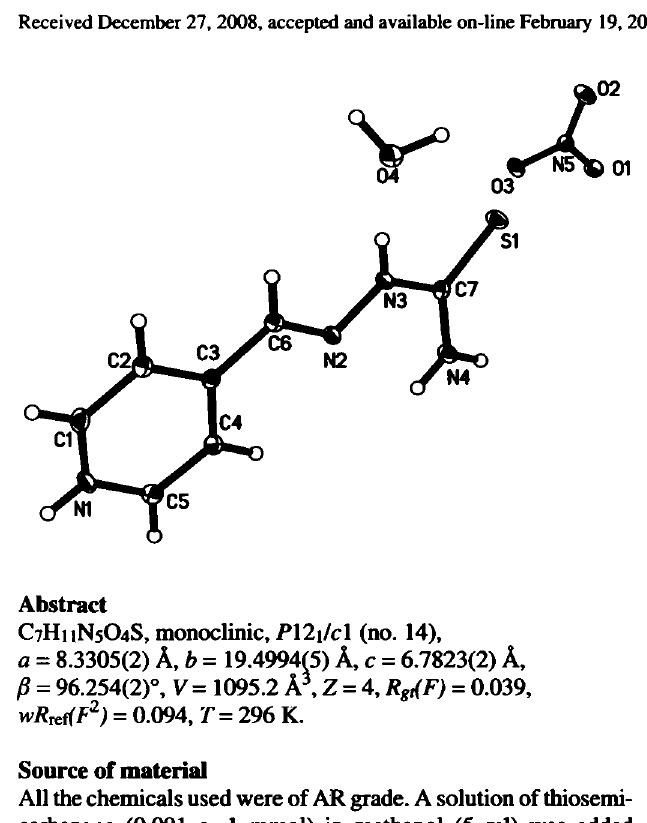
Table 2. Atomic coordinates and displacement parameters (in Â 2